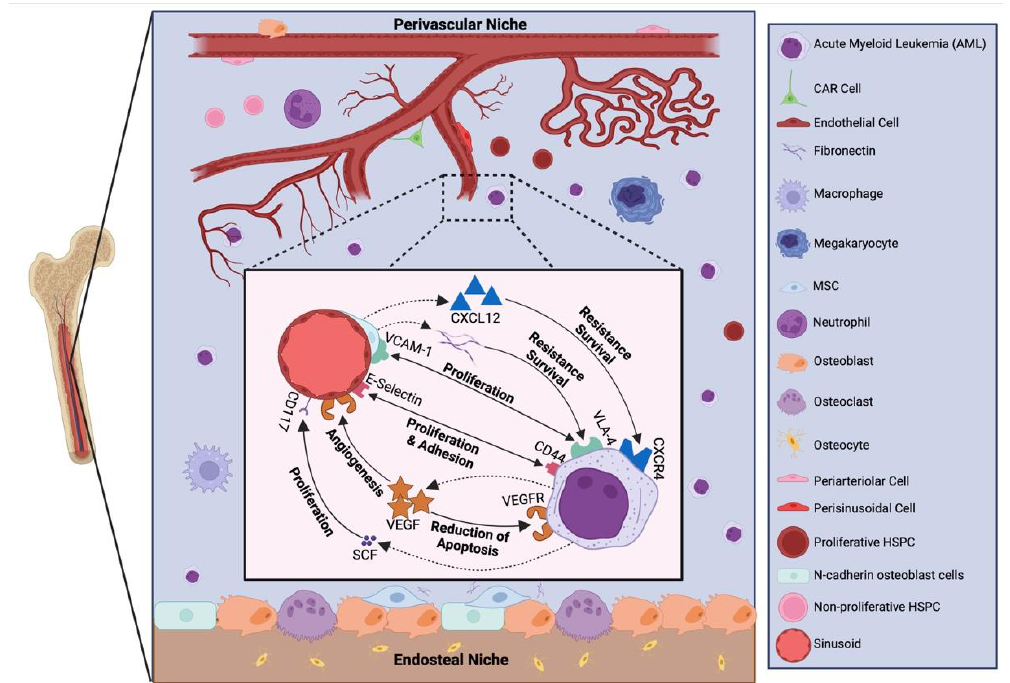
Figure 2. Leukaemic blast interactions with the bone marrow niche. A variety of secreted and cell – cell interactions can regulate the proliferation, survival and chemoresistance of AML cells. Many of these signalling pathways are under clinical investigation for targeted anti-AML therapies. CAR: CXCL12 abundant reticular cells; HSPC: haematopoietic stem/progenitor cell; MSC: mesenchymal stem cell; VCAM-1: vascular cell adhesion molecule 1; SCF: stem cell factor. Created with BioRender.com.